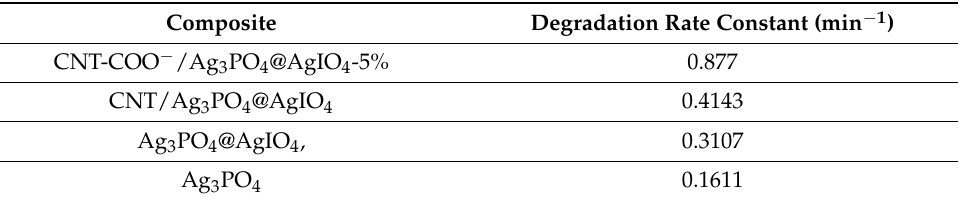
Figure 8. Stability and recycling of the CNT-COO − /Ag 3 PO 4 @AgIO 4 -5% composite. 2.3.5. Photocatalytic Activity Mechanism To investigate the effect of reactive species (h + , O 2• − , and • OH) on the photodegra- dation of organic pollutants, reactive species trapping experiments were carried out.It